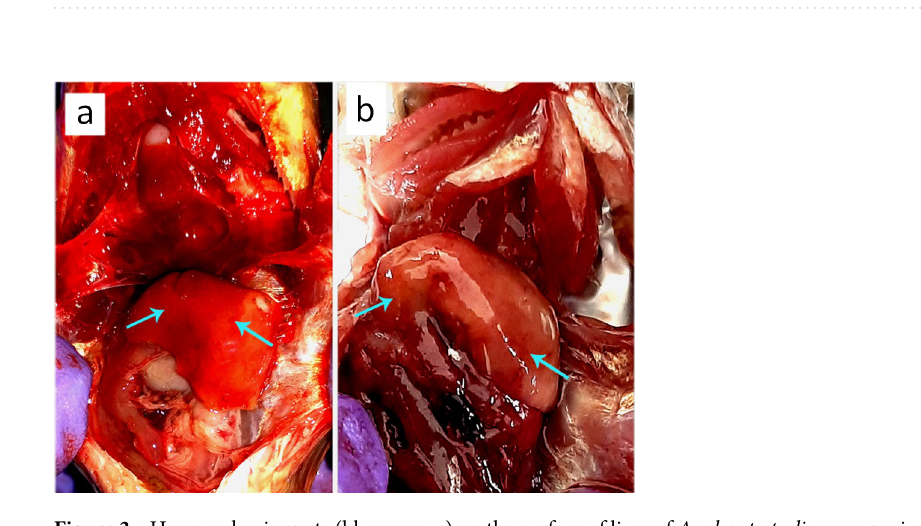
Figure 3. Haemorrhagic spots (blue arrows) on the surface of liver of Anabas testudineus experimentally- challenged with ( a ) Aeromonas hydrophila and ( b ) A. jandaei